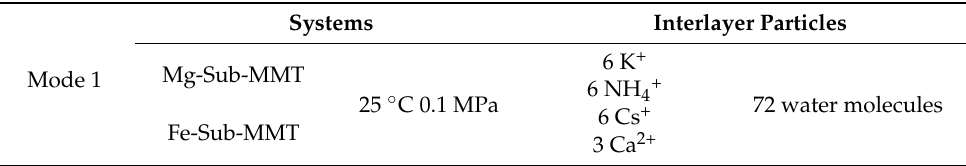
Table 1. Mode 1: Simulation scheme for changing the exchangeable cationic.